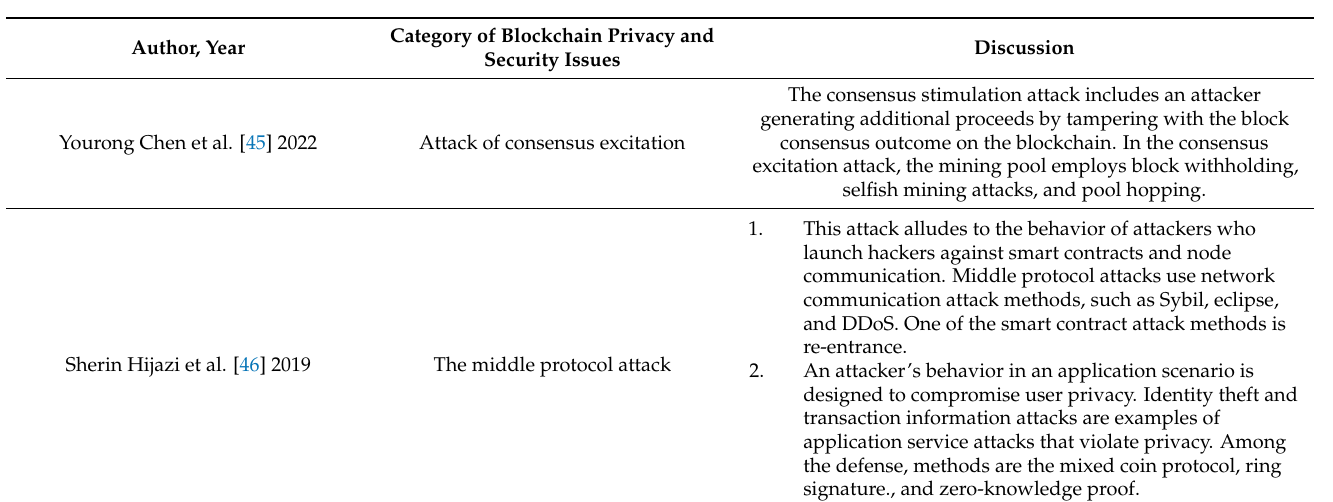
Table 2. Blockchain Privacy and Security